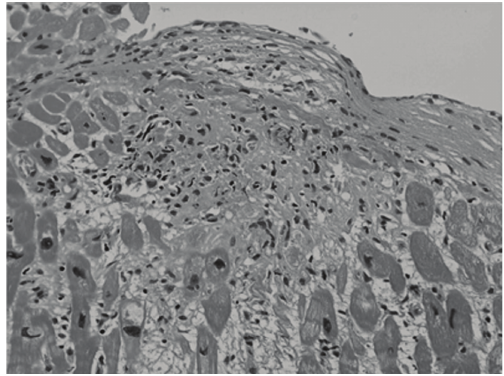
Figure 3: Hematoxylin-Eosin staining of the myocardium from ventricular septum discloses epithelioid cell